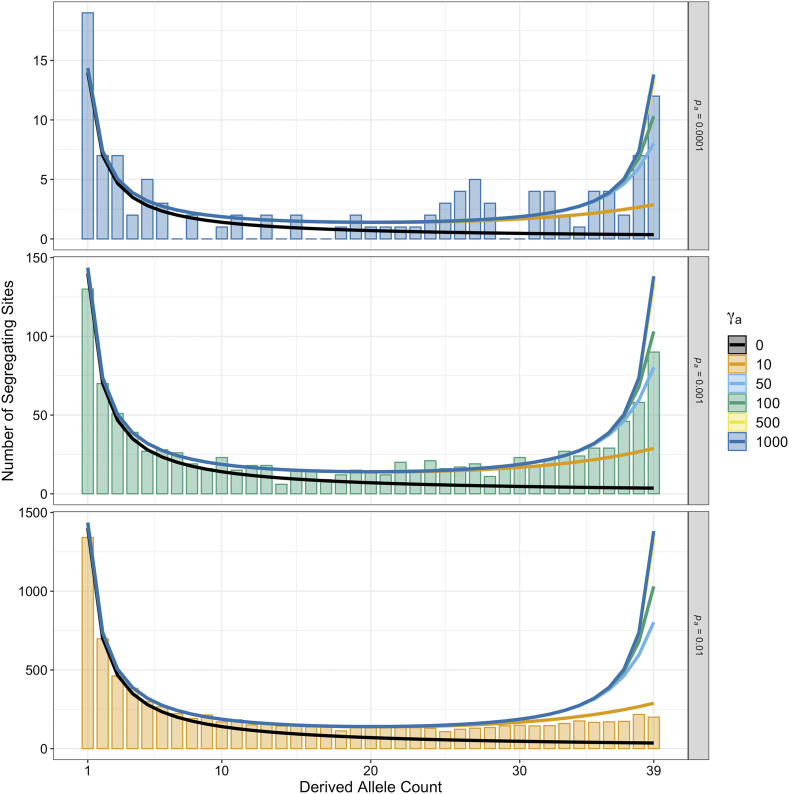
The uSFS for advantageous mutations under different combinations of positive selection parameters. The three bar charts show observed uSFS from simulations that model positive selection parameters that yield similar α. The lines in each panel show the expected frequency spectra for different strengths of beneficial mutations and were obtained using Equation 2 from Tataru et al., (2017).